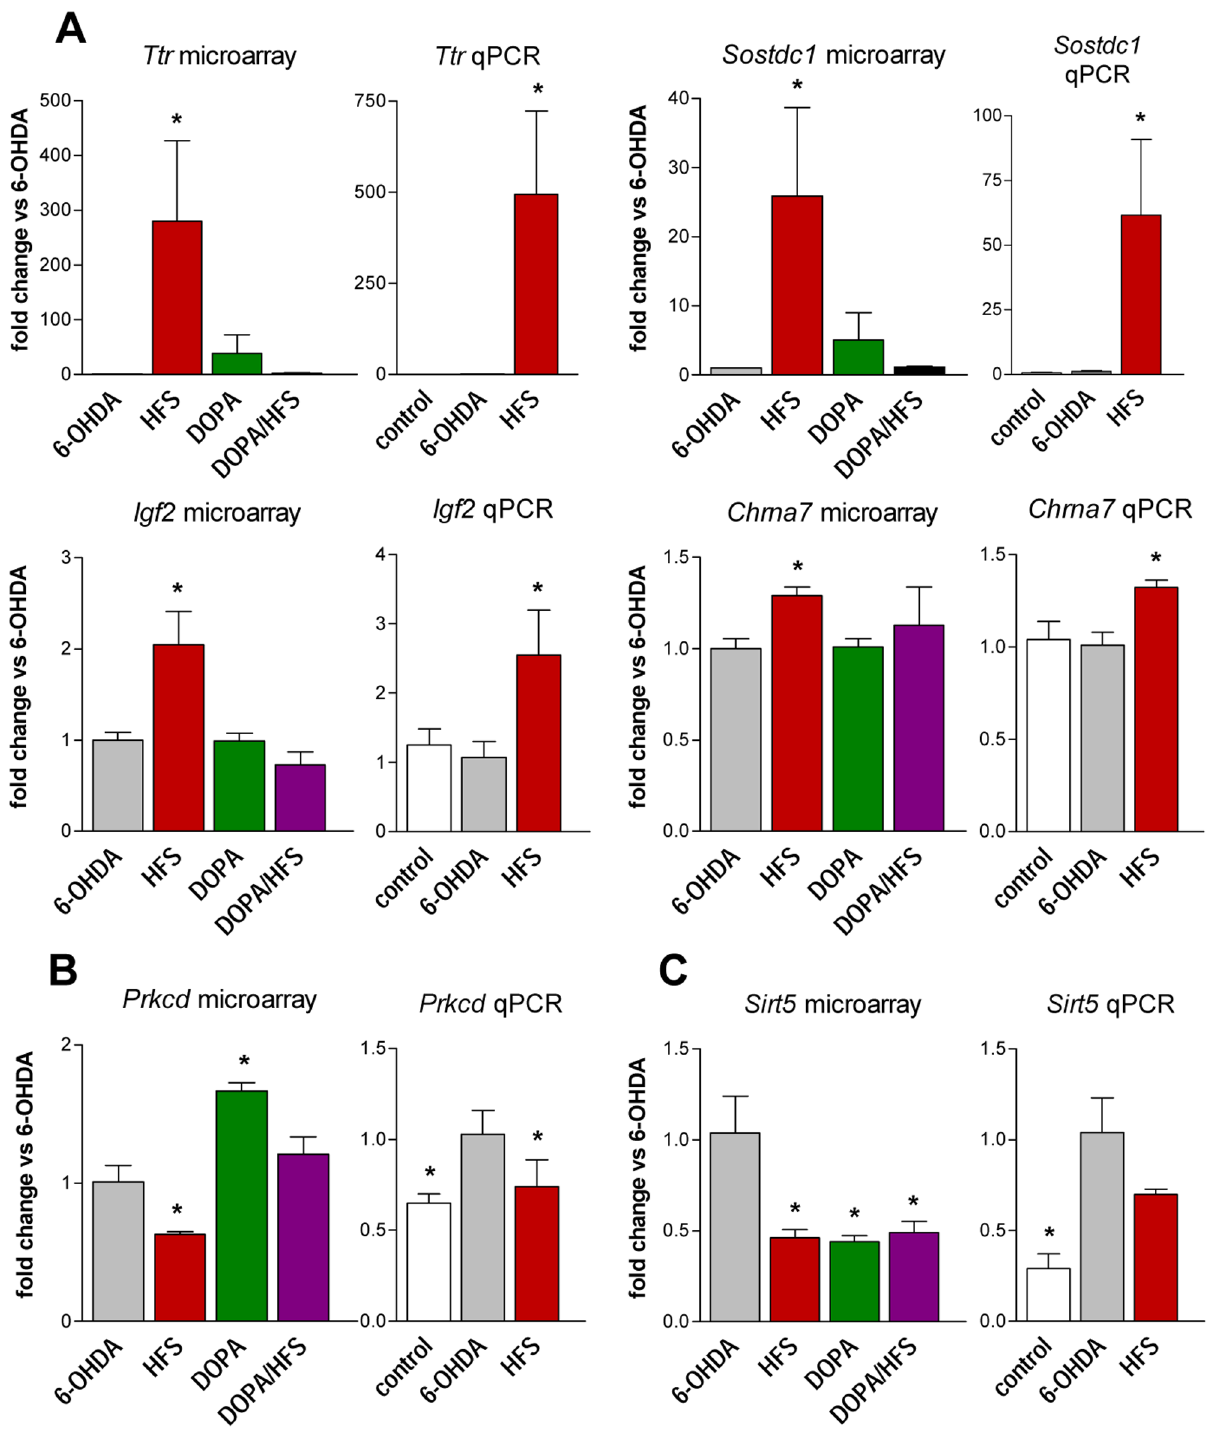
Figure 5. Comparison of the data obtained by microarray and RT-qPCR for 6 genes of interest. (A) Genes specifically up-regulated by HFS, (B) opposite regulation of Pkrcd by HFS and DOPA and (C) common down-regulation of Sirt5 by HFS and DOPA. Microarray experiments were performed on total striatal RNA samples from 6-OHDA, HFS, DOPA and DOPA/HFS groups. For qPCR validation of gene expression, total striatal RNA samples from 3 groups were analyzed: control, 6-OHDA and HFS. For both microarray and qPCR, results were calculated for each sample relative to the expression of the endogenous reference gene: HPRT, and fold change vs the 6-OHDA group was determined using the 2 2 DD Ct method. Values are presented as means 6 SEM. *p , 0.05 vs 6-OHDA values.